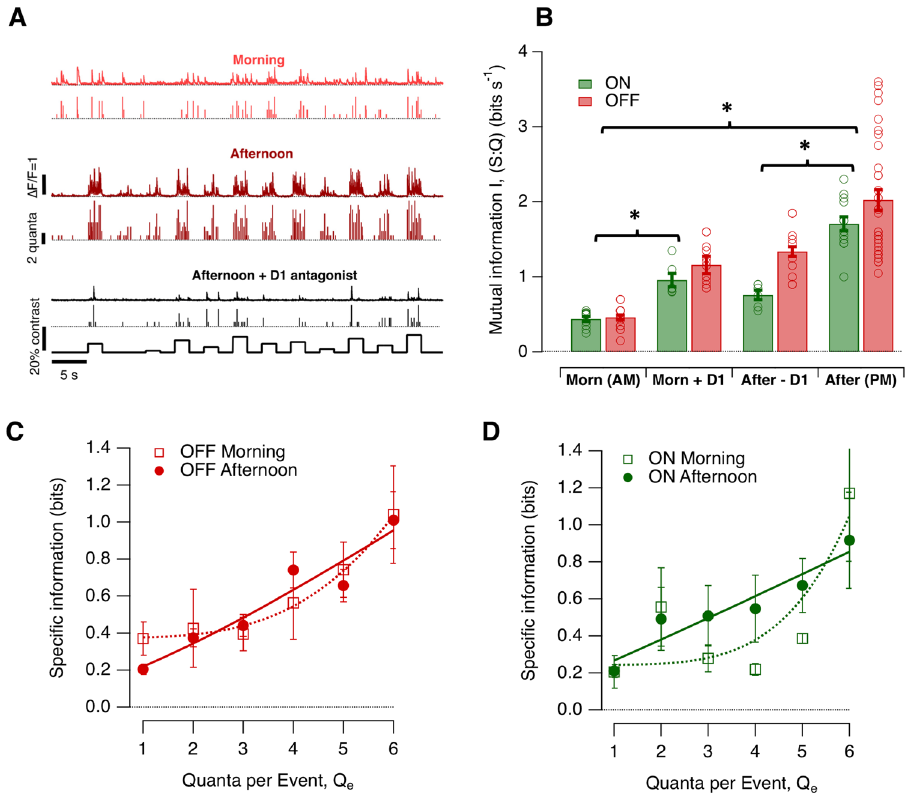
Fig. 8 Diurnal changes in the ef fi ciency with which synapses transmit visual information. A Examples of synaptic responses over 11 different contrasts spanning ±10% around the contrast eliciting the half-maximal response ( C 1/2 ) in the morning (top, light red), afternoon (middle, dark red) and after injection of D1 antagonist SCH 23390 in the afternoon (bottom, black; note the lower frequency and amplitude of release events). In each case the top trace shows the iGluSnFR signal and the lower trace the estimated Q e. Each contrast step lasted 2 s (5 Hz) and each trace is from a different OFF synapse. B Mutual information I (S:Q) in four conditions: morning (Morn AM; OFF = 15 synapses, ON = 10 synapses), morning after injection of ADTN (Morn + D1; OFF = 14 synapses, ON = 6 synapses), afternoon after injection of SCH 23390 (After − D1; OFF = 12 synapses, ON = 6 synapses) and afternoon (After PM; OFF = 33 synapses, ON = 13 synapses). Differences between morning and afternoon were signi fi cant at p < 0.0001 (One-way ANOVA), as were the effects of drug manipulations. Bar graphs show the mean ± s.e.m. Individual values are represented by green and red open dots for ON and OFF synapses, respectively. C Speci fi c information ( I ) for events of different quantal content in OFF synapses (morning, n = 15; afternoon, n = 33). The curve describing the relation are least-squares fi t of a power function of the form I = y0 + AQ e x . In the morning, y 0 = 0.38, A = 0.0017, x = 3.4. In the afternoon, y 0 = 0.12, A = 0.10, x = 1.2. Each point shows the mean ± s.e.m. D As ( C ), but for ON synapses (morning, n = 10; afternoon, n = 13). In the morning, y 0 = 0.24, A = 0.0003, x = 4.4. In the afternoon, y 0 = 0.16, A = 0.11, x = 1.0. Each point shows the mean ± s.e.m. Source data are provided as a Source Data fi